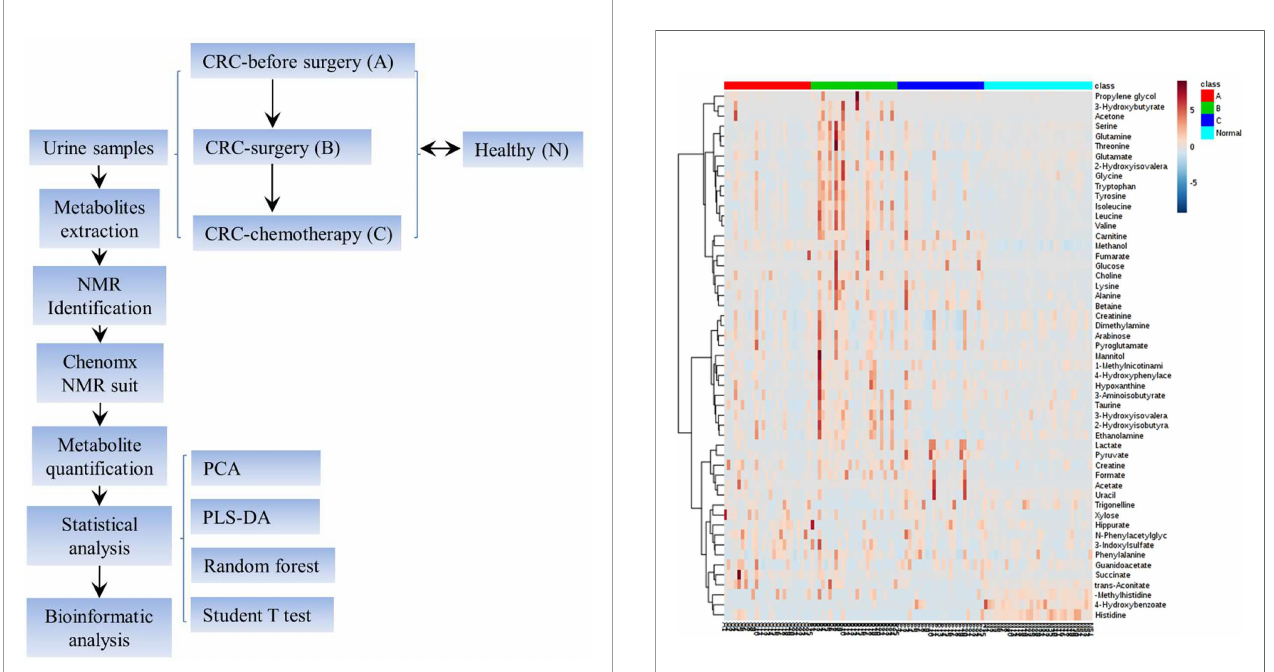
FIGURE 2 | Heatmap representation of all metabolites detected in this study among the four clinical groups. Metabolites with similar pro fi les among the four clinical groups are clustered on the y-axis of this